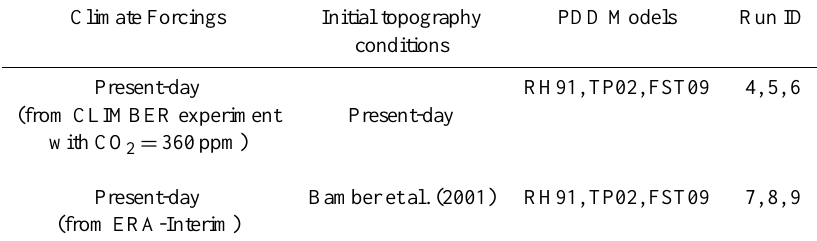
Table 2a. GRISLI equilibrium simulations: present-day.